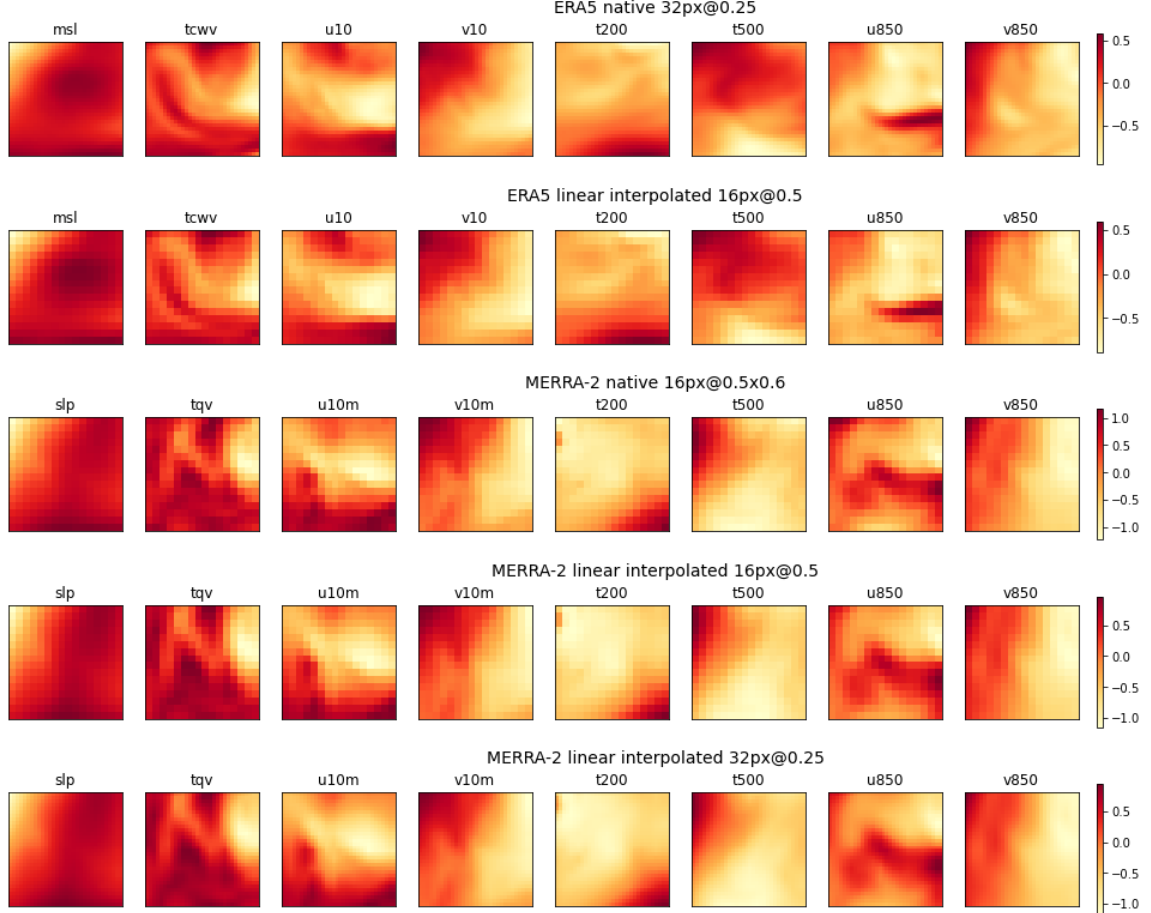
Figure 5. Same as Fig. 4 but for the background image on 6 August 1987, 18:00UTC, centered on 35.5 ◦ N, 43.125 ◦ W. Data are